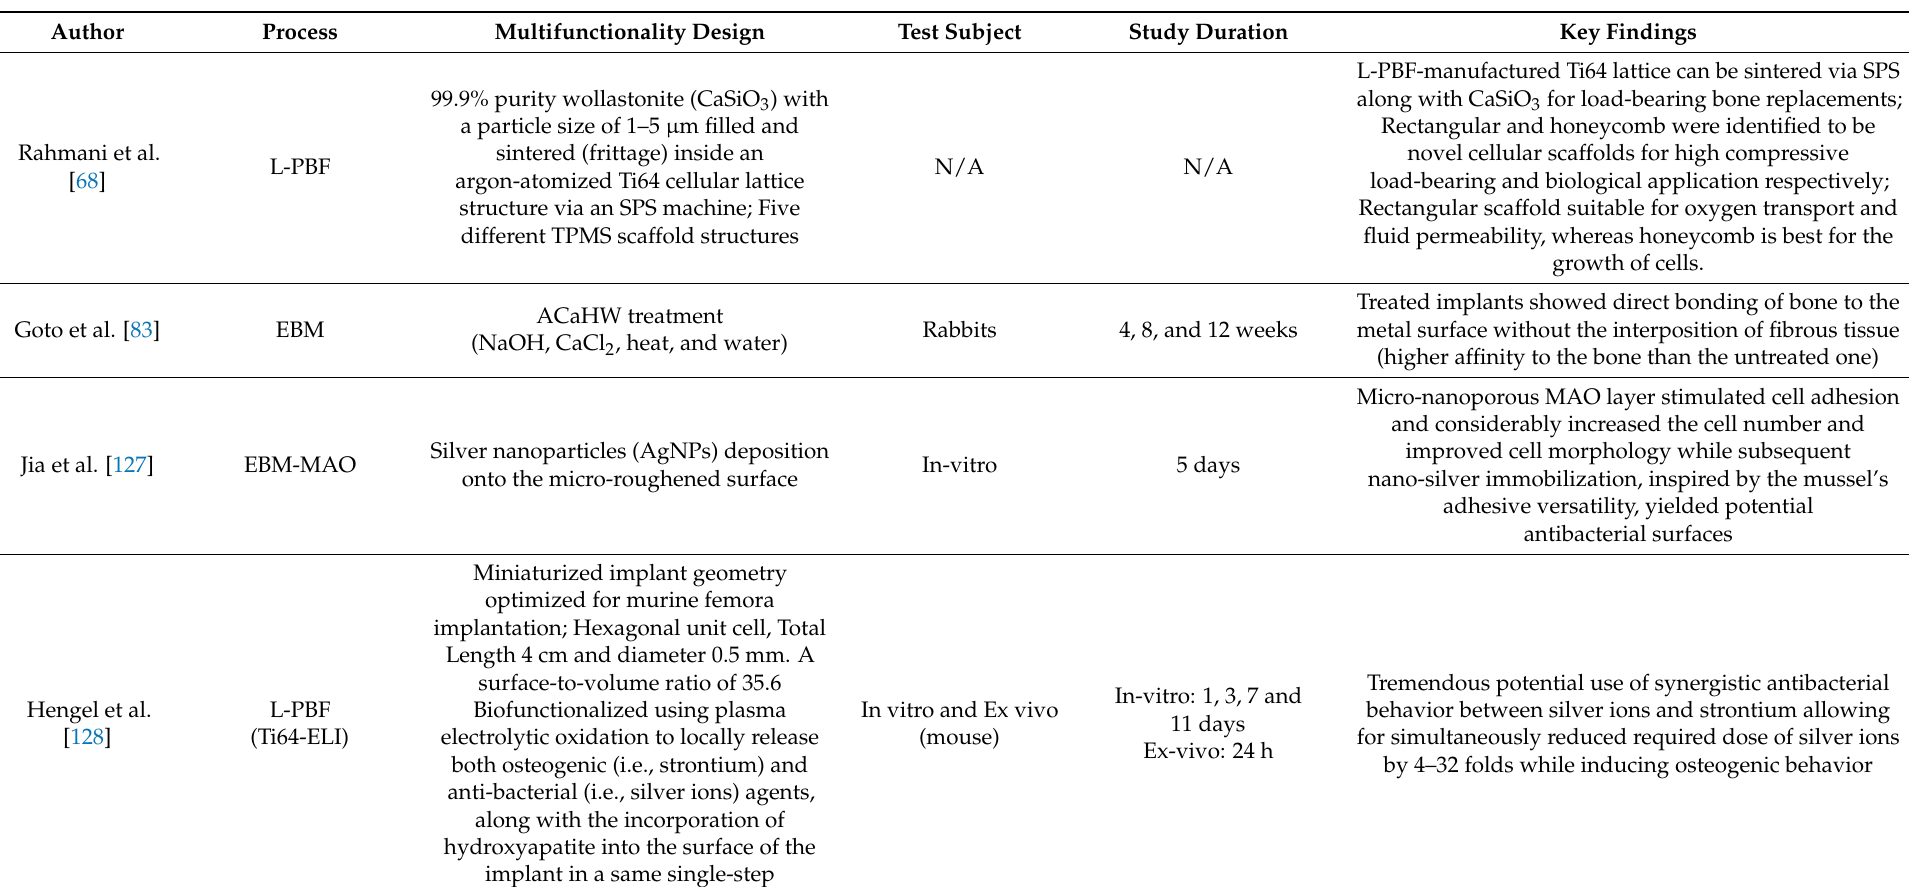
Table 5. Multifunctional Porous